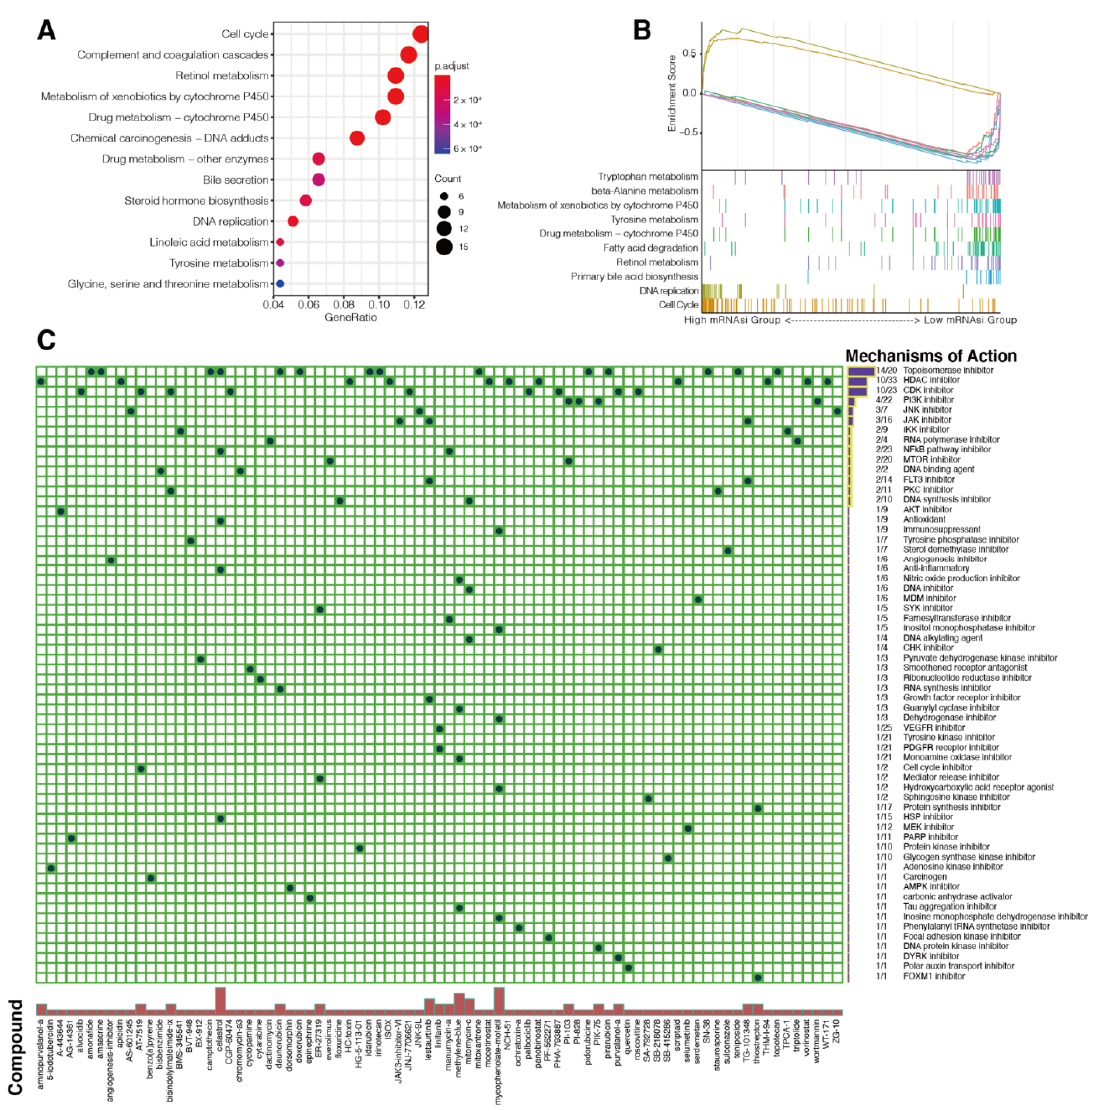
Figure 7. Screening of potential compounds targeting HCC cancer stemness using the cMAP data set. Pathway enrichment analysis ( A ) of DEGs between the high and low mRNAsi groups of 1059